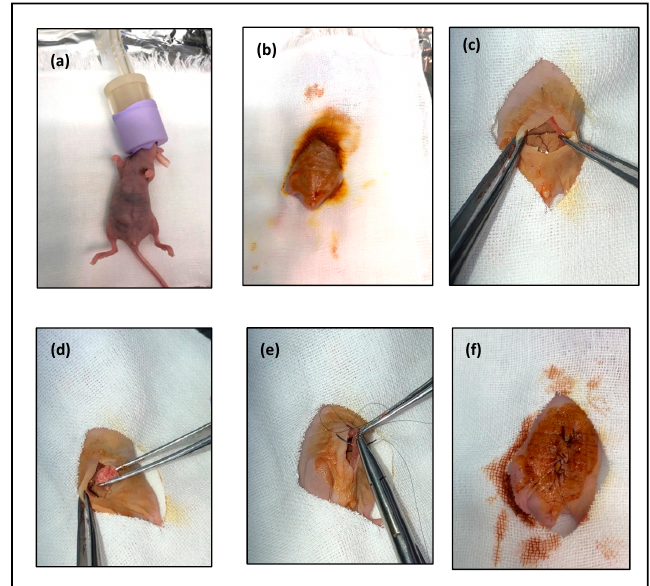
Figure 2. Fresh surgically resected mouse malignant tumor tissue ready to be transplanted.